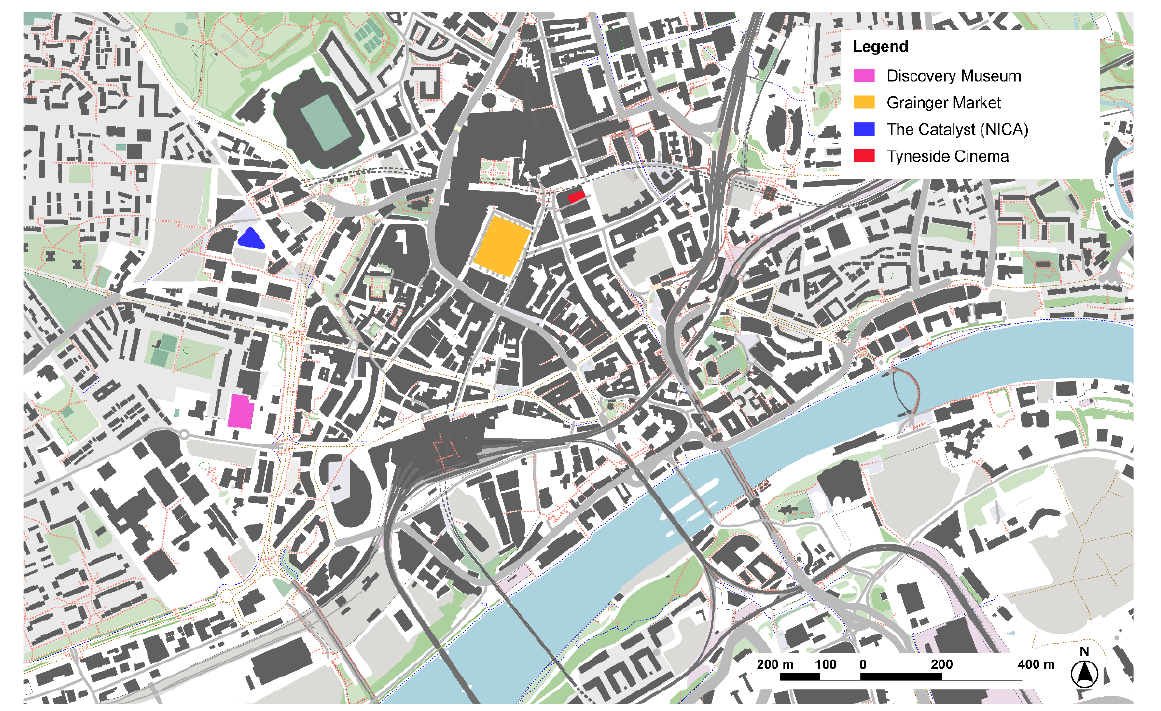
Figure 2. Main innovative dementia-friendly projects in Newcastle-upon-Tyne, United Kingdom. Source: Own elaboration.